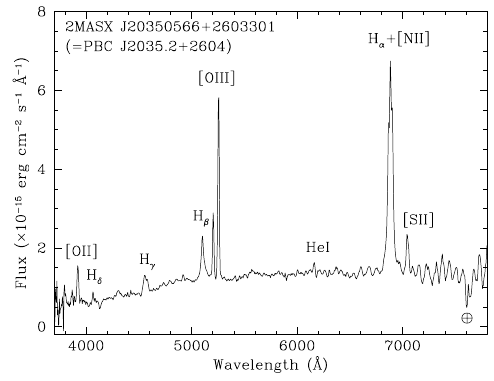
Figure 5: Optical spectrum (not corrected for the in- tervening Galactic absorption) of a typical Narrow-line Seyfert 1. The main spectral features are